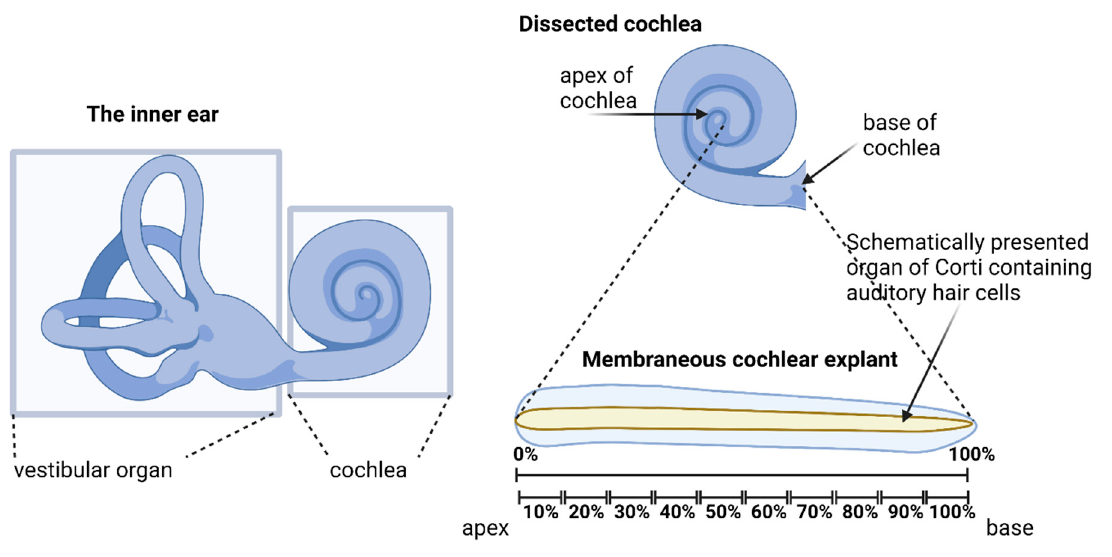
Figure 10. Illustration of the hair cell scoring approach along the cochlear length. That approach was used to deliver the cochleogram data presented in Figure 7. Created with BioRender.com. The hair cells were classified into three morphological groups: intact, damaged, and missing. Intact hair cells were characterized by physiologically arranged stereocilia